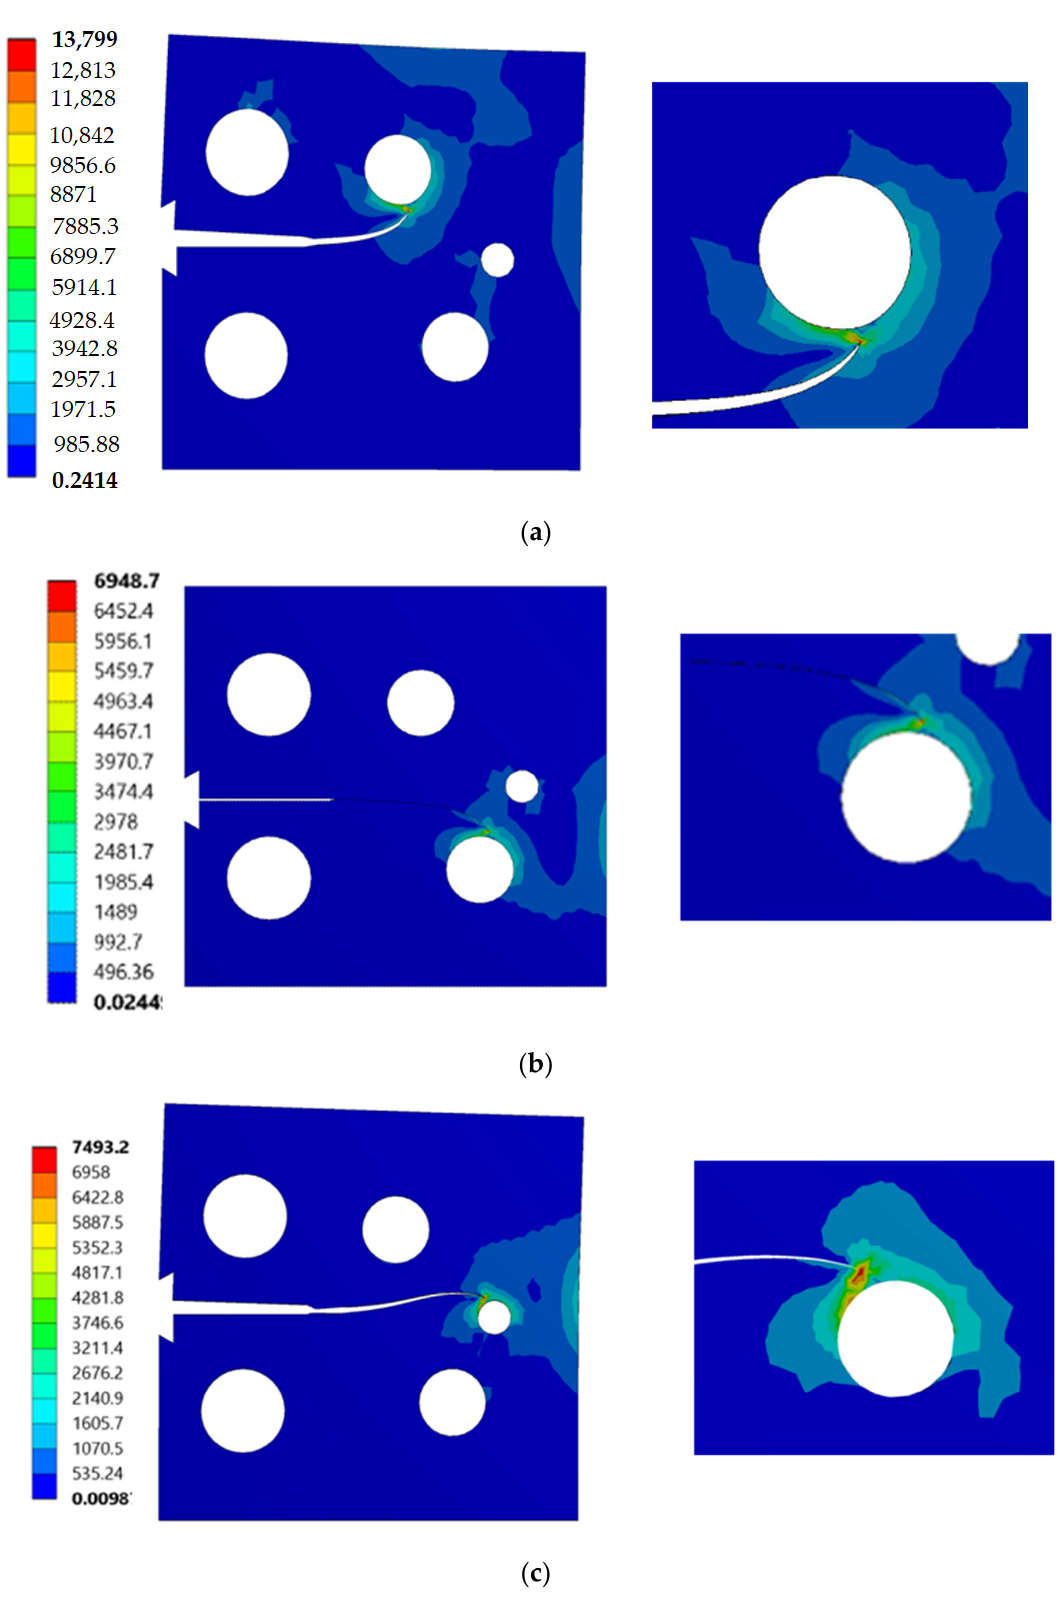
Figure 12. Distribution of von Mises stress (MPa): ( a ) case 1, ( b ) case 2, and ( c ) case 3.